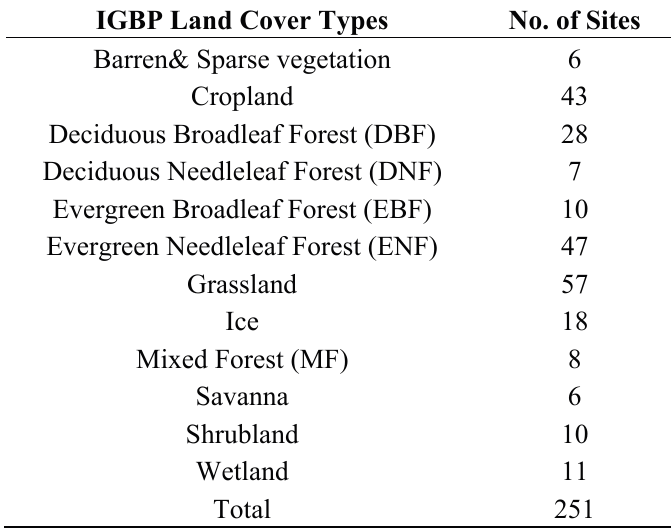
Table 2. Number of sites for each International Geosphere-Biosphere Programme (IGBP) land cover types.